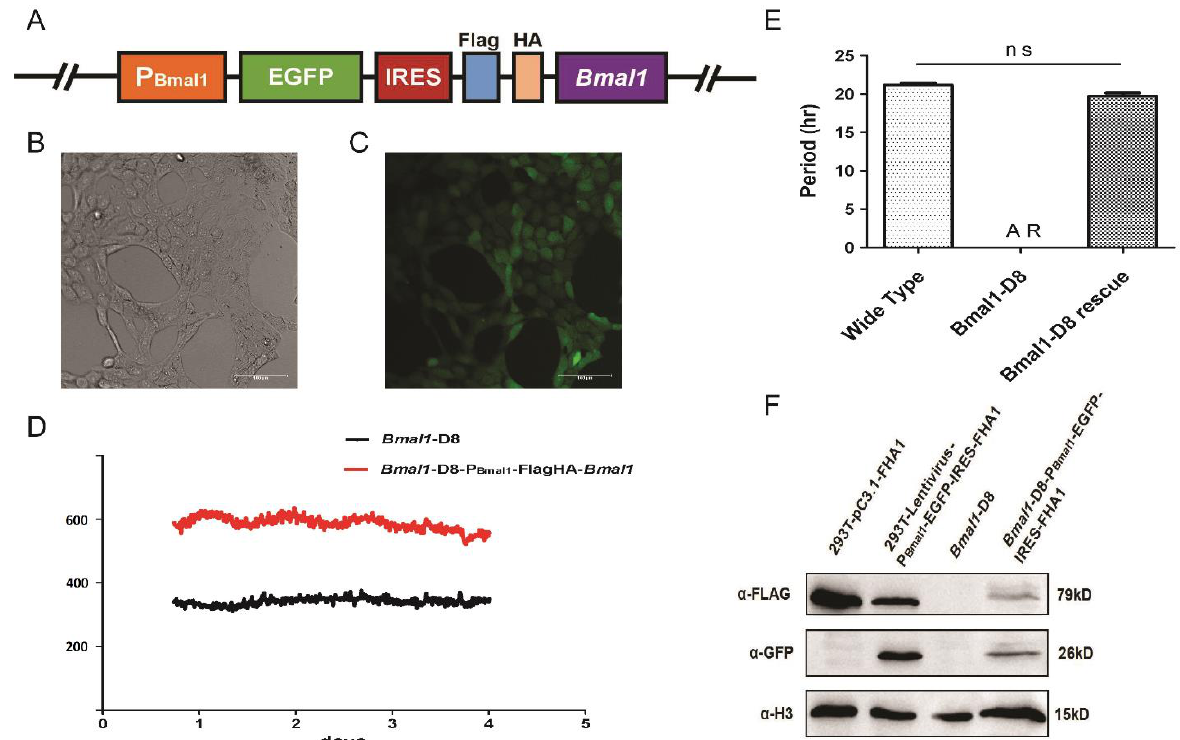
Figure 2. The lentivirus of exogenous Bmal1 driven by the Bmal1 promoter rescues the circadian phenotype of Bmal1 -D8. ( A ) Illustration of the main components of the new constructed lentiviral complement vector, in which the Flag-HA tagged Bmal1 is driven by the native Bmal1 promoter. ( B ) Bmal1 -D8 cells were transfected with the new lentiviral vector and the bright filed image is shown. ( C ) The fluorescent image of Bmal1 -D8 cells transfected with the new lentiviral vector indicates that GFP is successfully expressed. ( D ) The bioluminescence rhythm results of Bmal1 -D8 and lentivirus infected Bmal1 -D8-P Bmal1 -FlagHA- Bmal1 cells. ( E ) The calculated circadian period of wide type, Bmal1 -D8, Bmal1 -D8 rescue cells. Bmal1-D8 rescue cells showed a period closed to that of the wild-type cells. ( F ) Western blot images show that the GFP and Flag-HA tagged Bmal1 can simultaneously express in both HEK293T and Bmal1 -D8 cells. Histone3 are shown here as loading controls. ns, none significant. Representative luminescent trace or image was shown.